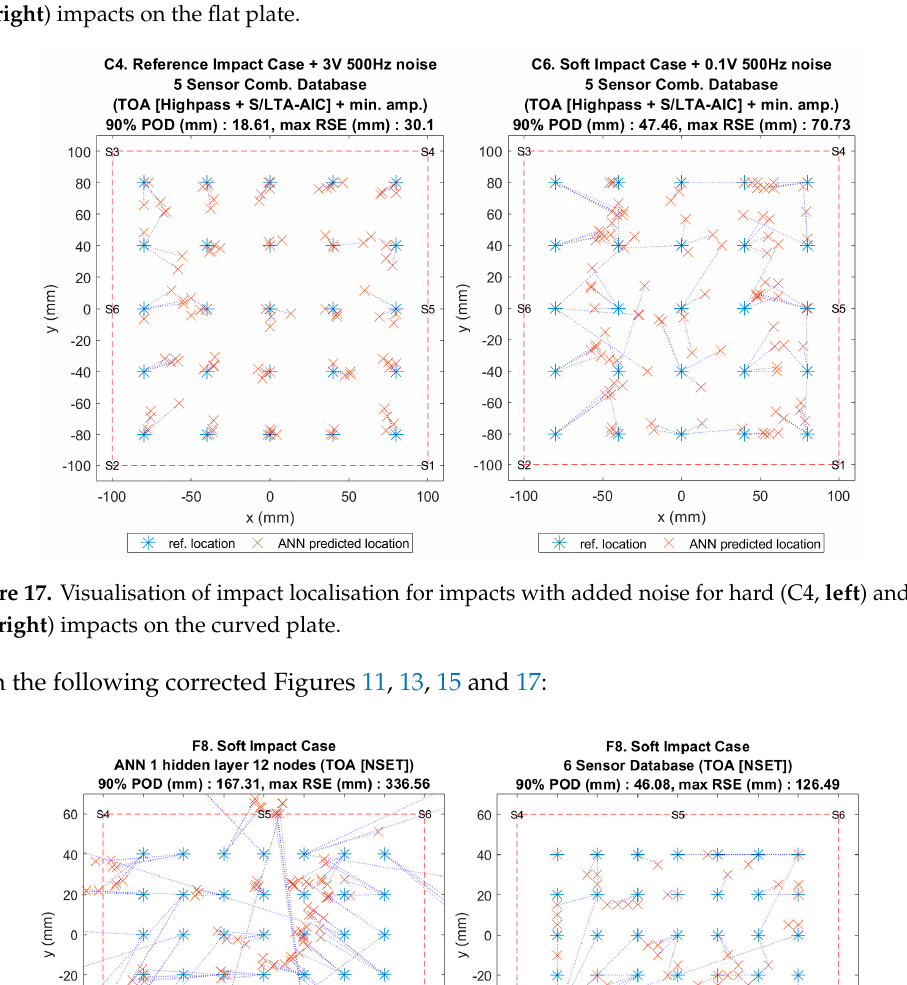
Figure 15. Visualisation of impact localisation for impacts with added noise for hard (F7, left) and soft (F9, right) impacts on the flat plate.